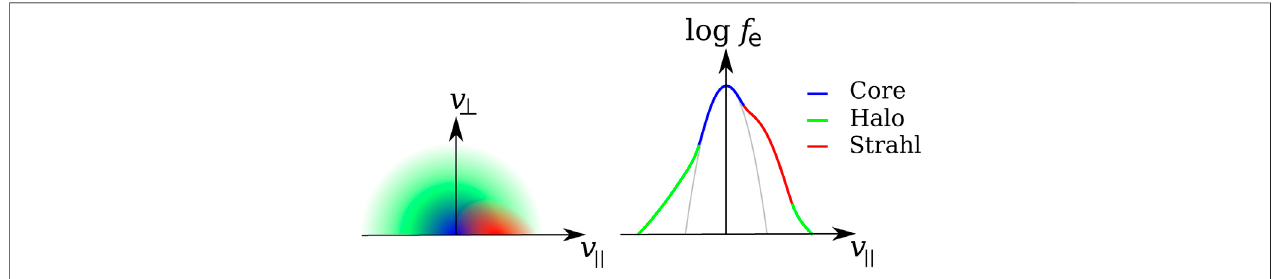
FIGURE 1 | Schematic of a typical electron distribution function in the solar wind. Left: two-dimensional distribution function in ( v ⊥ , v (cid:2) ) space. Right: cut of the distribution function along the v (cid:2) -axis. The blue colour indicates the electron core, the green colour represents the halo, and the red colour represents the strahl.